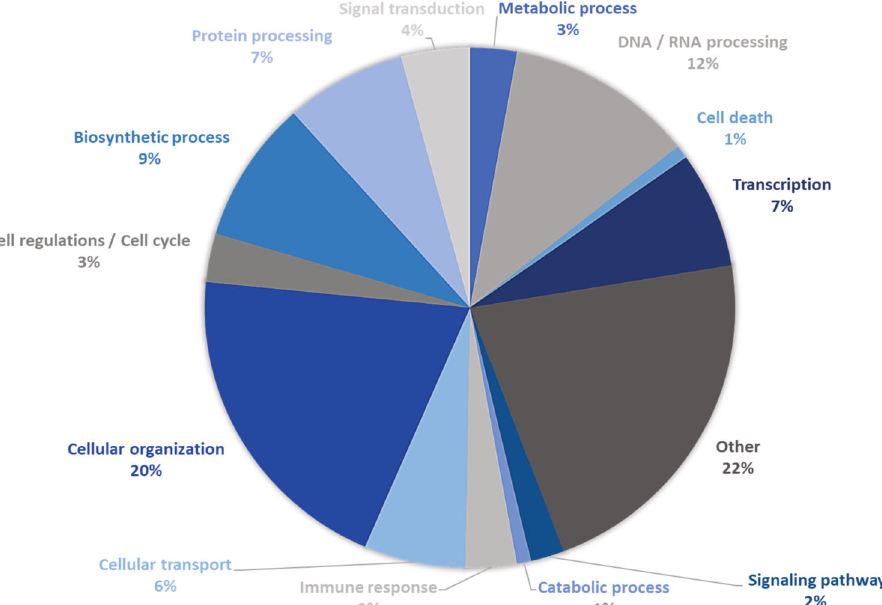
Fig. 5 Function lost genes clustering. Biological clustering of genes identi fi ed as having lost their function based on their functional